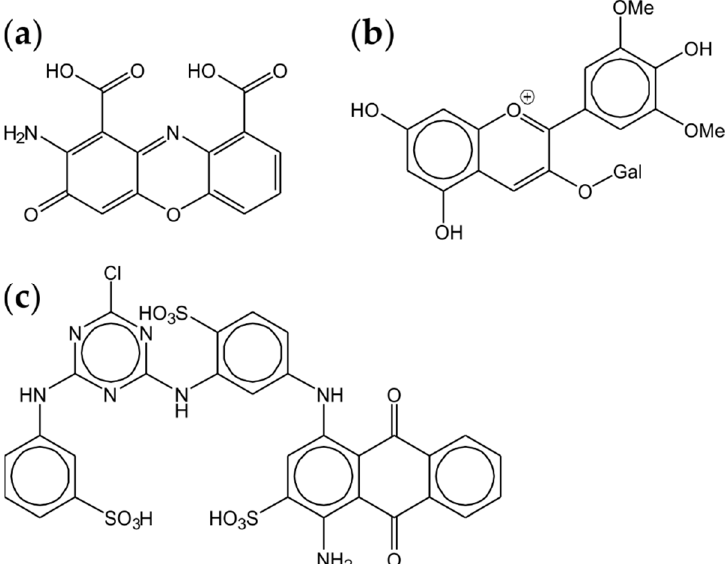
Figure 4. Structures of industrially interesting colourants, which are produced or degraded by ba ‐ sidiomycetes. ( a ) Cinnabarinic acid, a deep ‐ red colourant; ( b ) malvidin ‐ 3 ‐ O ‐ galactoside, a major basidiomycetes. ( a ) Cinnabarinic acid, a deep-red colourant; ( b ) malvidin-3- O -galactoside, a major colourant of red wine husks; ( c ) Reactive Blue 5, an anthraquinone dye. colourant of red wine husks; ( c ) Reactive Blue 5, an anthraquinone